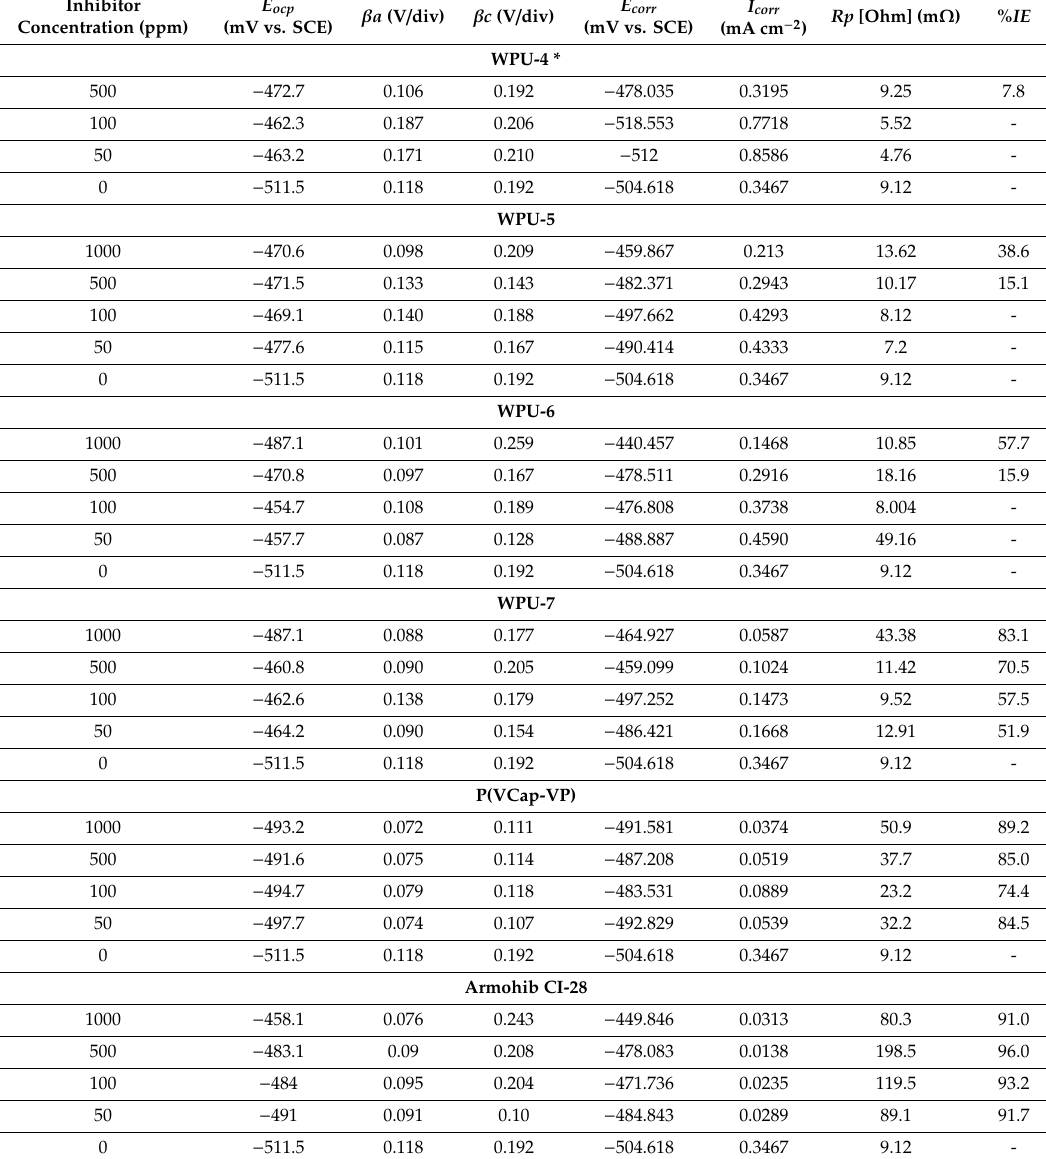
Table 2. Kinetic parameters for corrosion in the presence of WPU inhibitors at various concentrations. Inhibitor Concentration